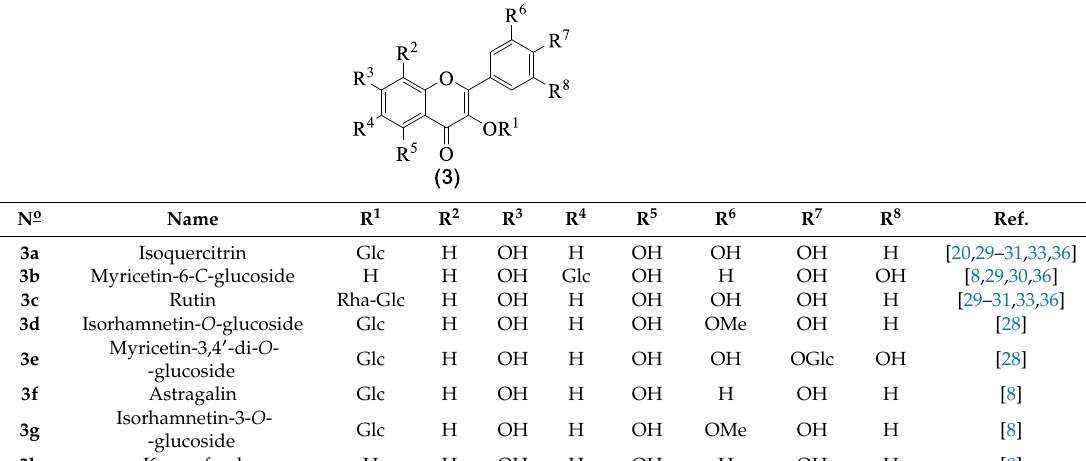
Table 3. Flavonols produced by G. tridentata .